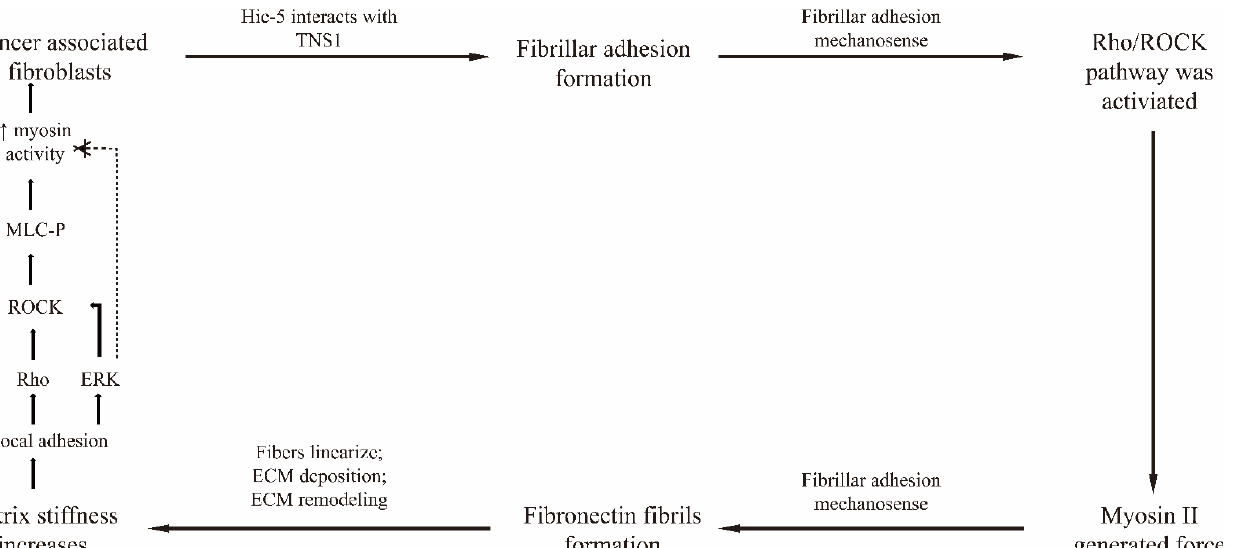
Table 1. Positive and negative regulatory mechanisms of TNS1 in different tumors.